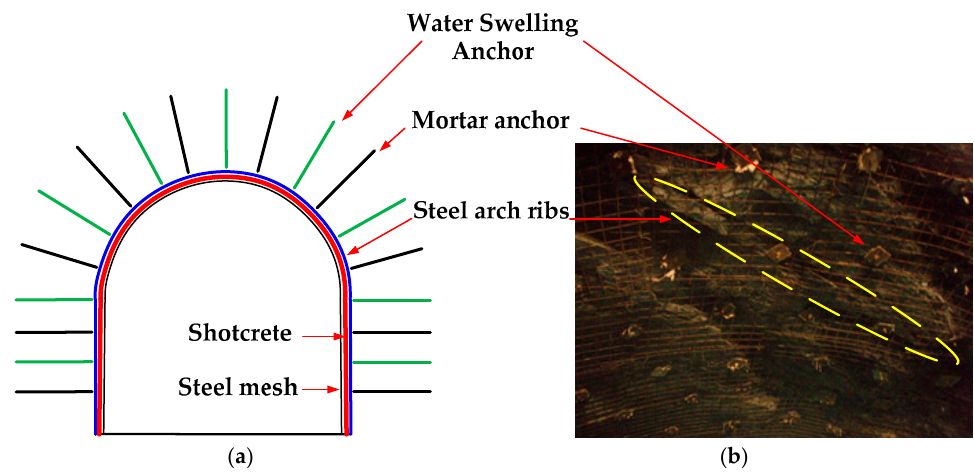
Figure 16. Combined rapid support: ( a ) Cross section diagram and ( b ) steel mesh and steel arch ribs.